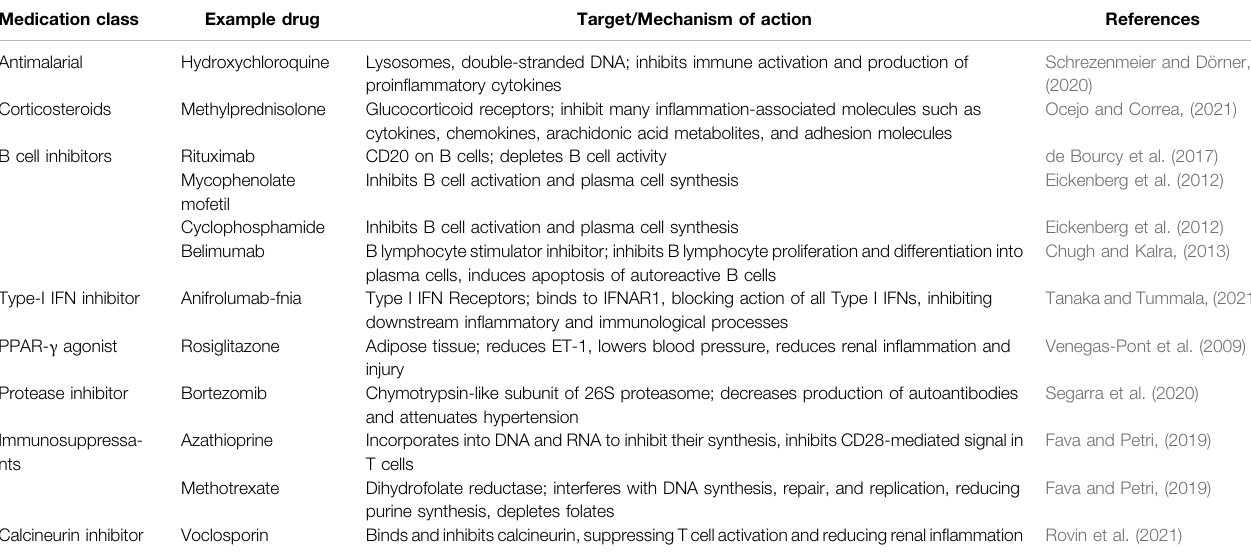
Table 2 DNA — deoxyribonucleic acid; RNA — -ribonucleic acid; IFN — interferon; IFNAR1 — subunit one of the type 1 interferon receptor; PPAR γ — peroxisome proliferator activator receptor-gamma; ET-1 — Endothelin-1.